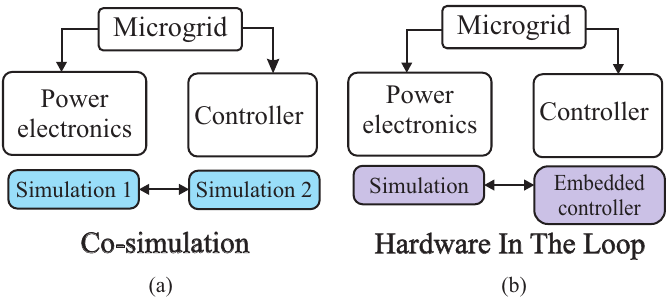
Figure 3. RT simulation strategies: ( a ) Co-simulation; ( b ) Hardware in the